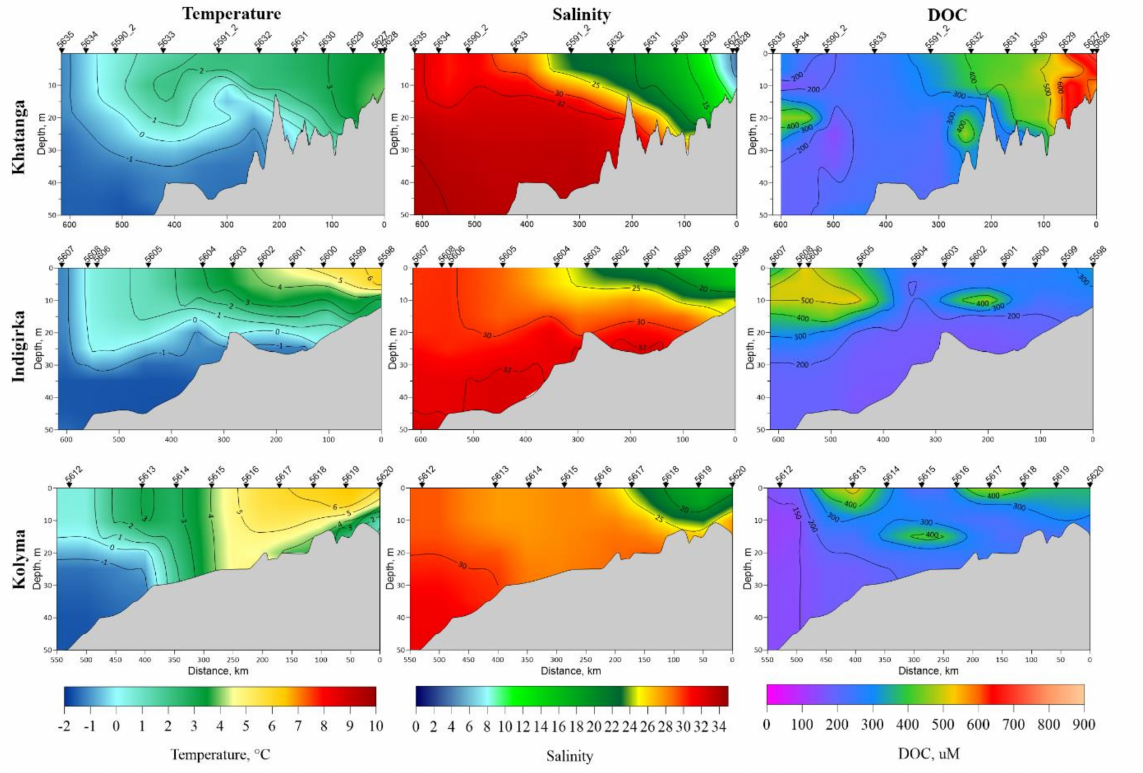
Figure 5. Distribution of temperature, salinity, and DOC along the Khatanga, Indigirka, and Kolyma